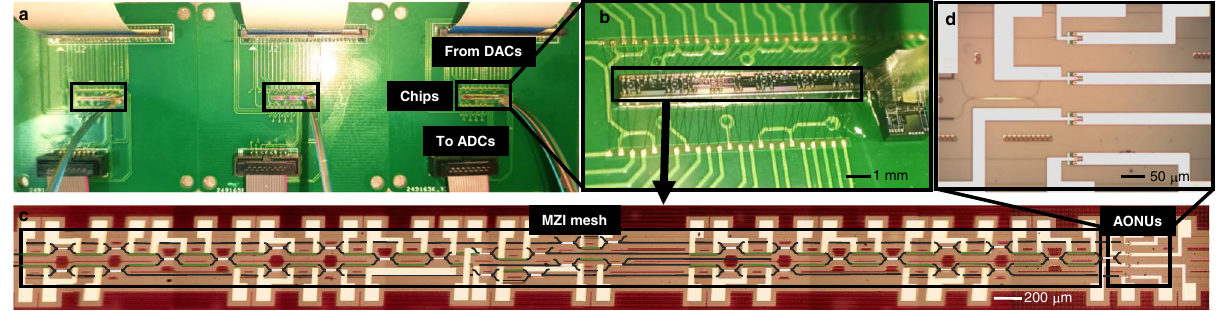
detailed AONUs of a single layer. The structure of each AONU has been shown in Fig.